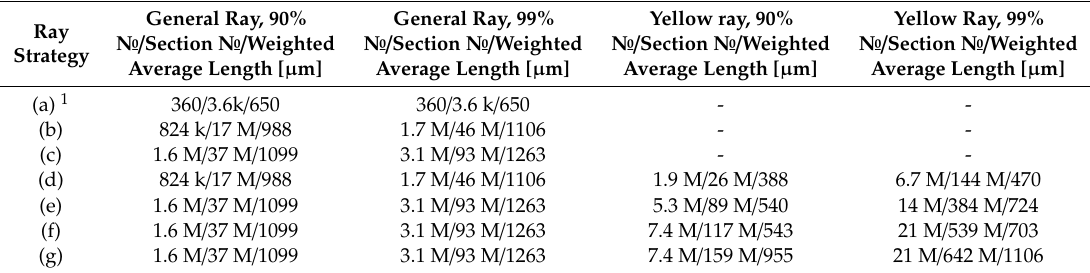
Table 3. General and yellow ray numbers of the half CoB LED model in the case of five blue rays / junction. General Ray, 90% Ray № / Section № / Strategy